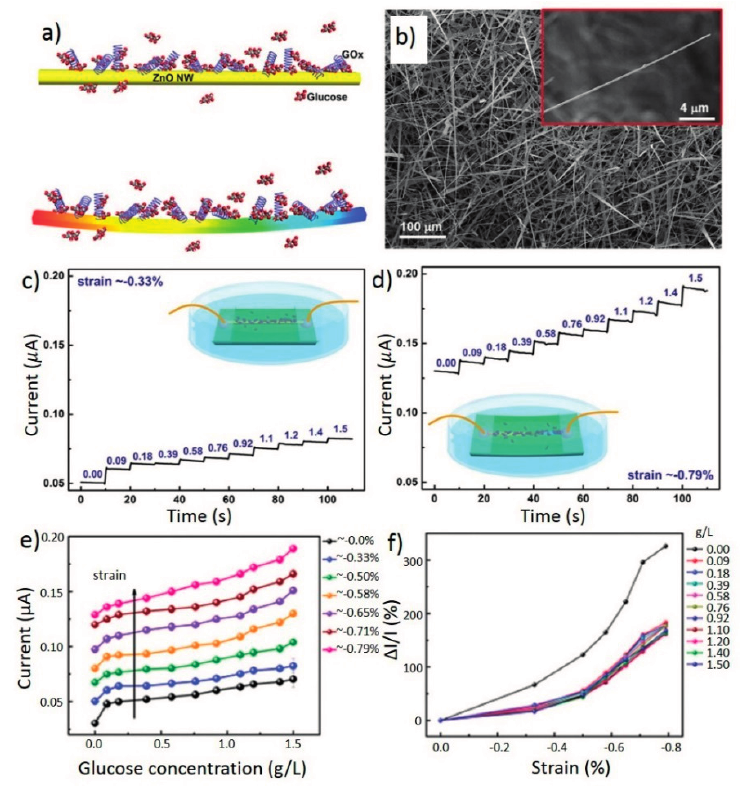
Figure 7. Schematic of the ZnO nanowire glucose sensor and its performance. ( a ) Unstrained and strained single ZnO nanowire functionalized with GOx; ( b ) SEM image of the as-synthesized ZnO nanowire. Inset image is a magnified view of a single wire; I-t characteristics of the single wire sensor as glucose is added over time under ( c ) 0.33% compressive strain and ( d ) 0.79% compressive strain. The glucose concentrations are in gL − 1 ; Absolute ( e ) and relative ( f ) current response of the glucose sensor under different glucose concentrations, from 0 to 1.5 gL − 1 and strains, from 0% to − 0.79%. Adapted from [72] with permission